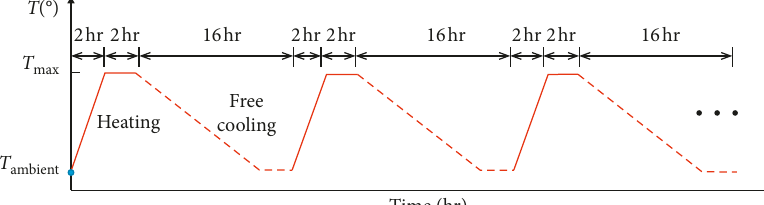
Figure 2: Thermal cycling